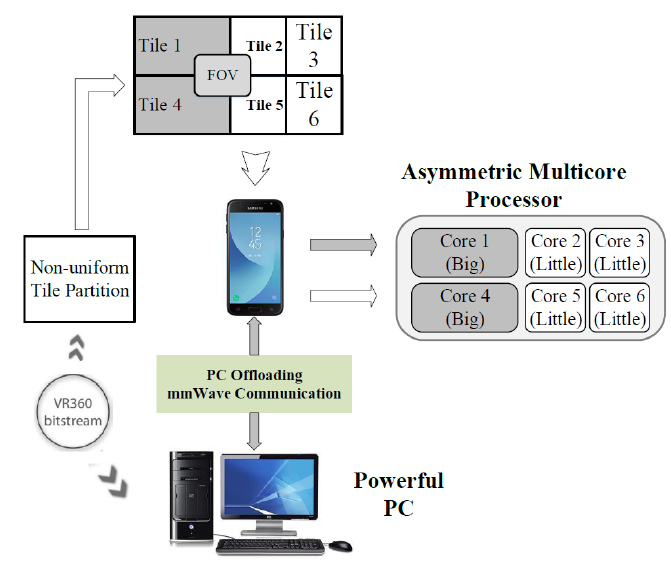
Figure 6. The proposed conceptual